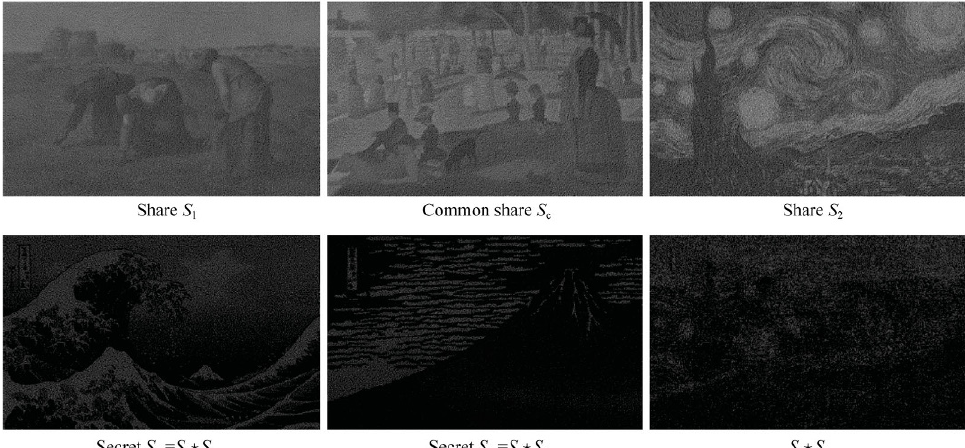
Fig. 4 EVCS results for grayscale images. The original images are 1200 × 750 pixels. The input images are shown in Fig. 11(bottom) in the Appendix.